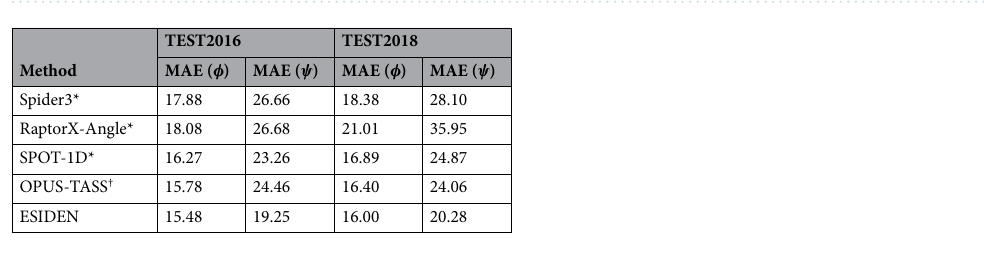
Table 3. Performance of different methods on the TEST2016 and TEST2018. *The results are obtained from the SPOT-1D 27 paper. † The results are collected from the OPUS-TASS 8 paper.